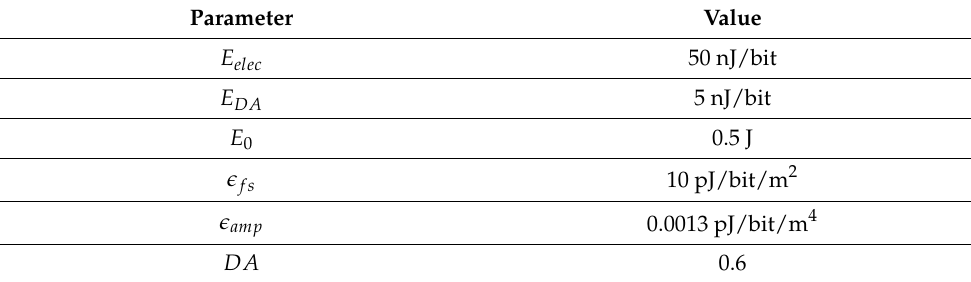
Table 1. Parameter